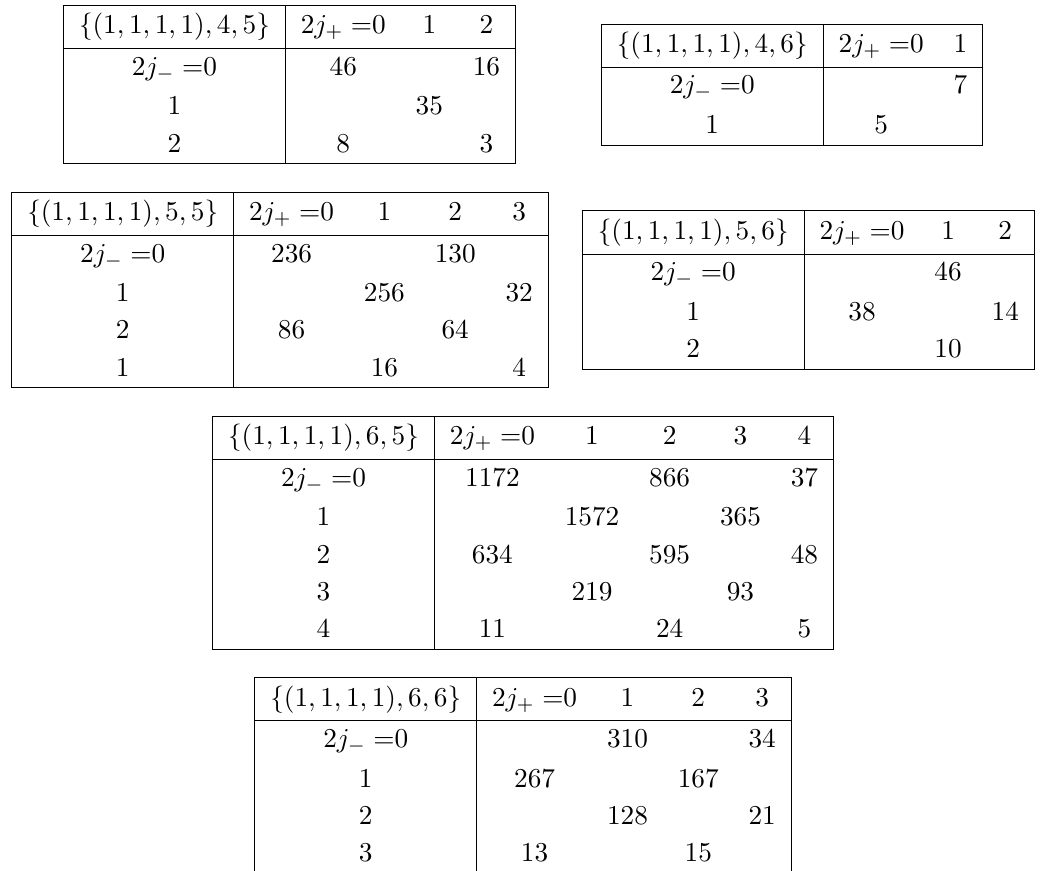
Table 15 . Refined GV invariants from 5d N = 2 gauge theory of type F 4 , fiber degree 4, 5 and 6 with mass degree 5 and 6